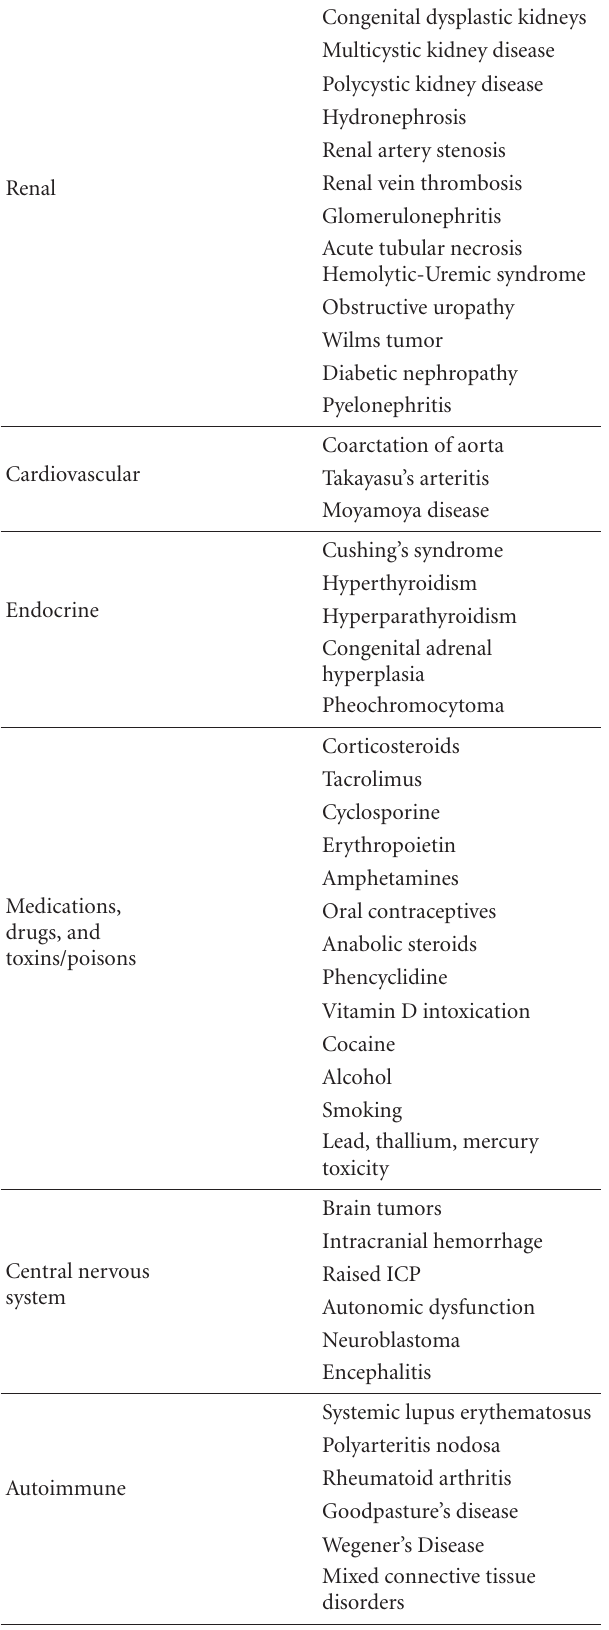
Table 2: Causes of hypertension in